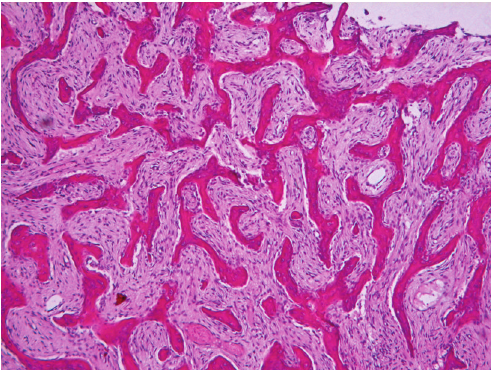
Figure 8: Fibrous dysplasia. Irregular trabeculae of woven bone lie in a monotonous fibrous stroma.